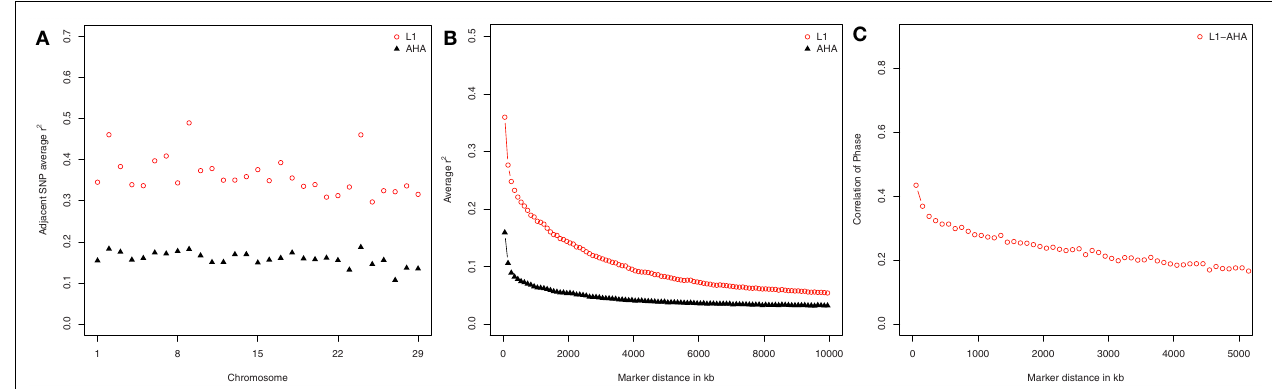
FIGURE 1 | Estimates of linkage disequilibrium (r2) across chromosomes (A) and marker spacing (B) for Line 1 Hereford (L1) and the general Hereford population (AHA), and the persistence of phase between them (C).